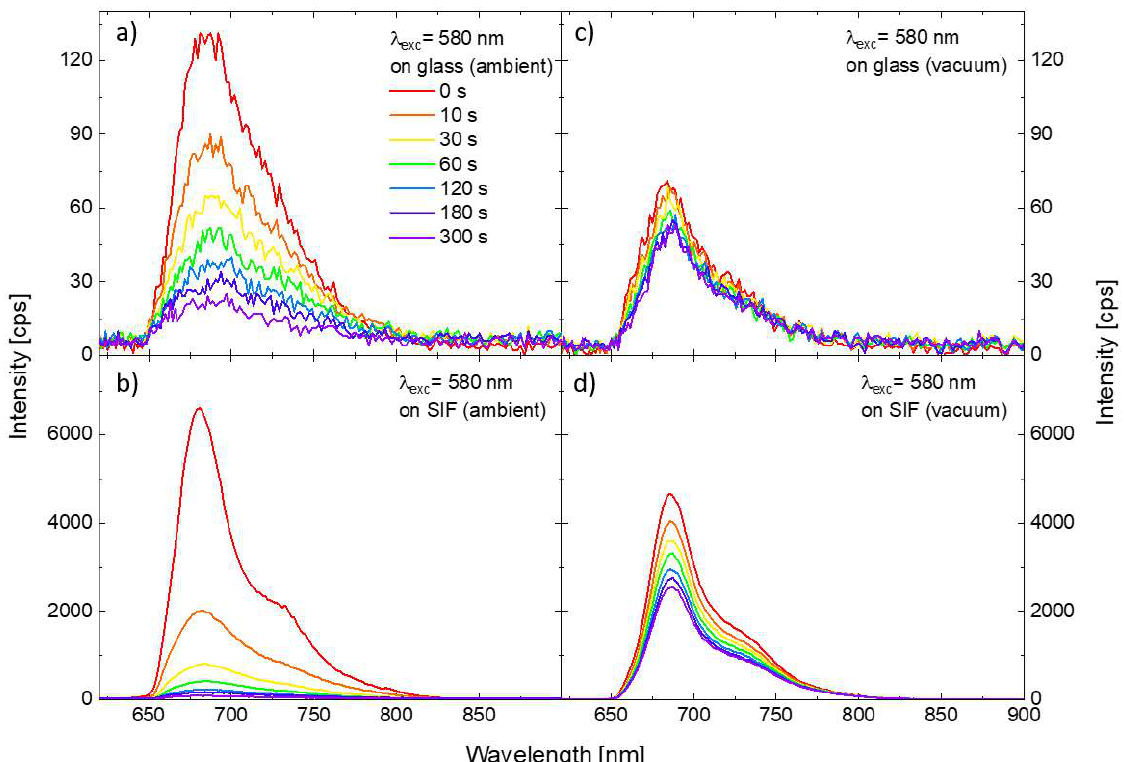
Figure 3. Temporal changes in the emission spectra of the PSI–LHCI layer deposited on the glass ( a ) and on the SIF ( b ) under excitation at 580 nm in the ambient conditions. Analogous results sets obtained for the samples kept in the vacuum are shown in the panels ( c , d ).